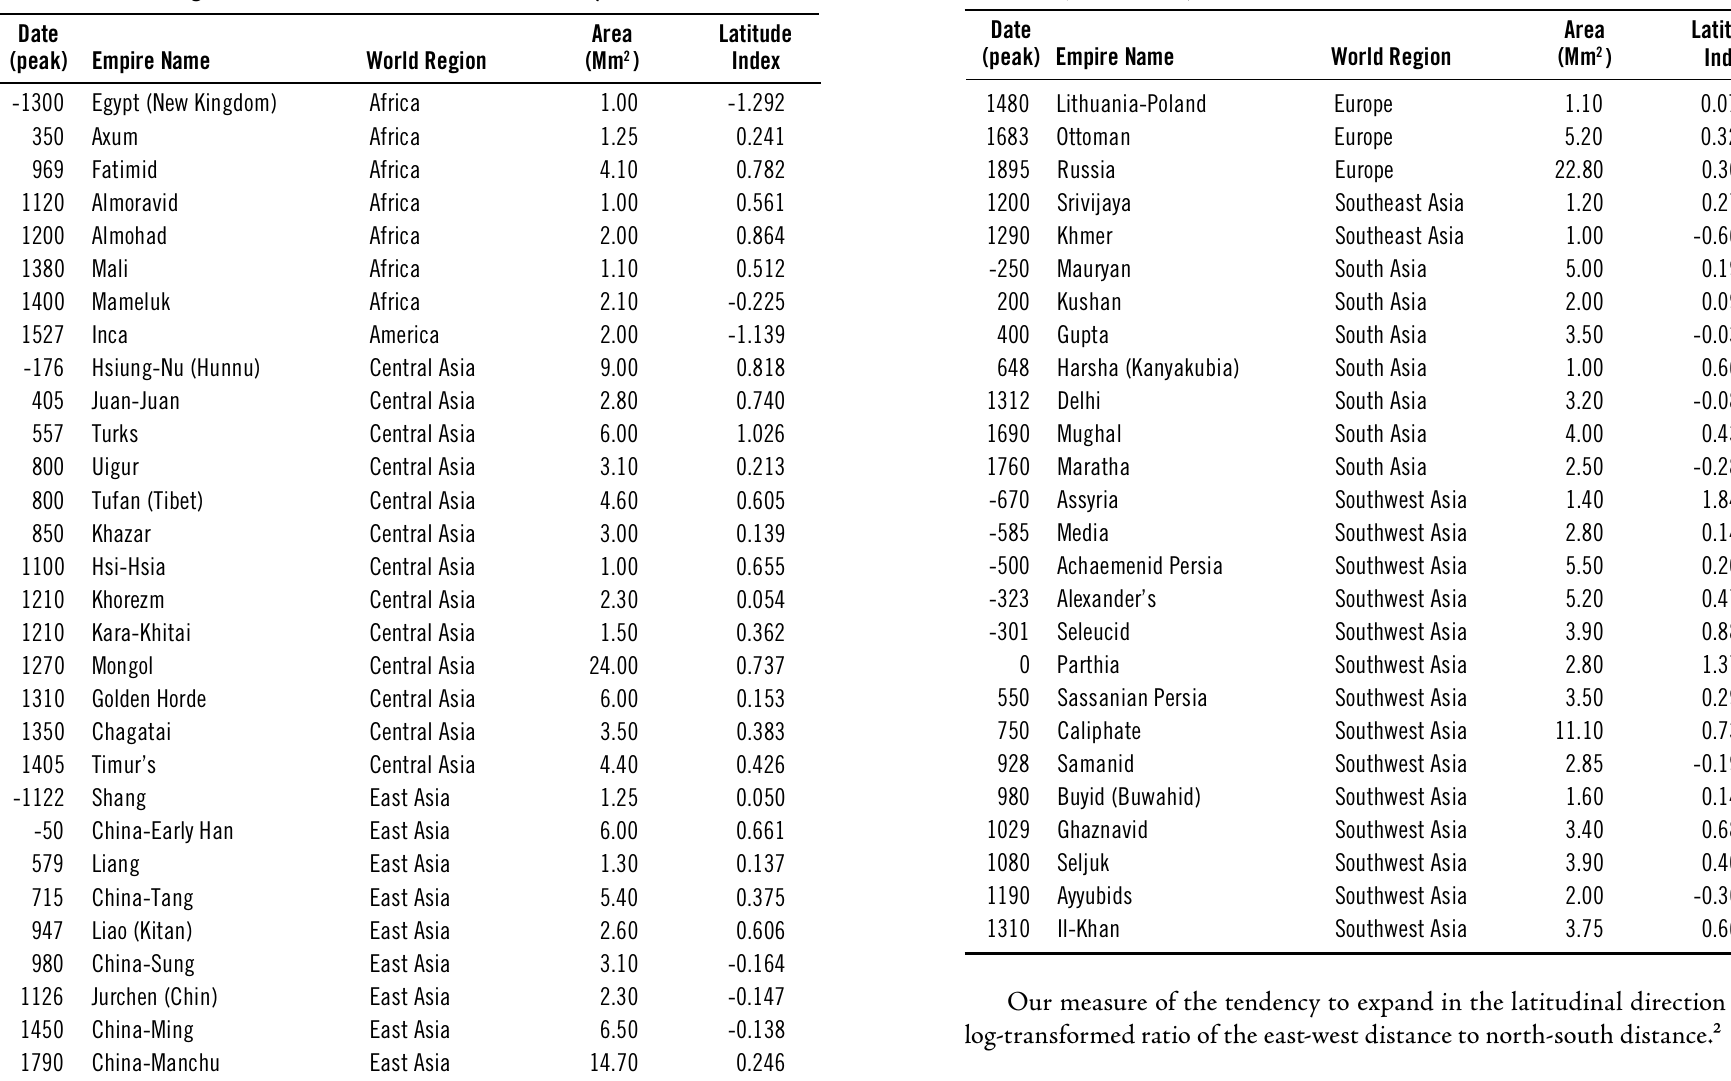
Table 1 – The Large Historical States Used in the